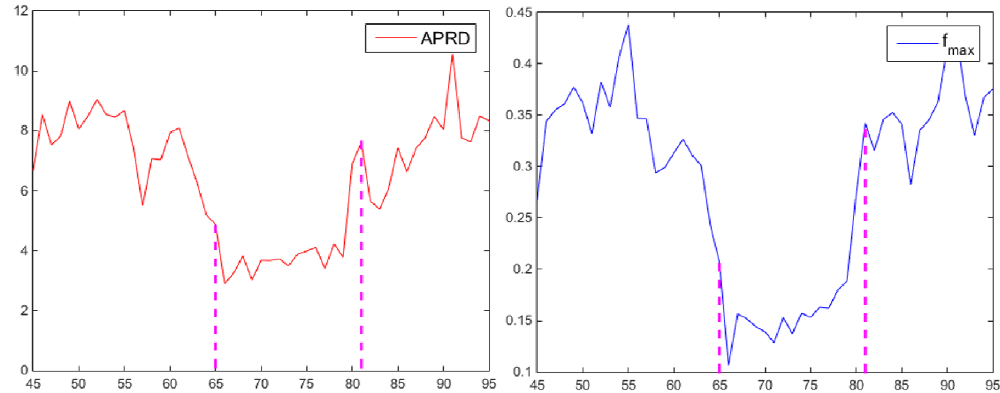
Figure 5. The blue curve and the red curve above respectively show how f max and APRD varies between the 45th frame to the 95th frame. The occlusion occurred between the 64th frame to the 81th